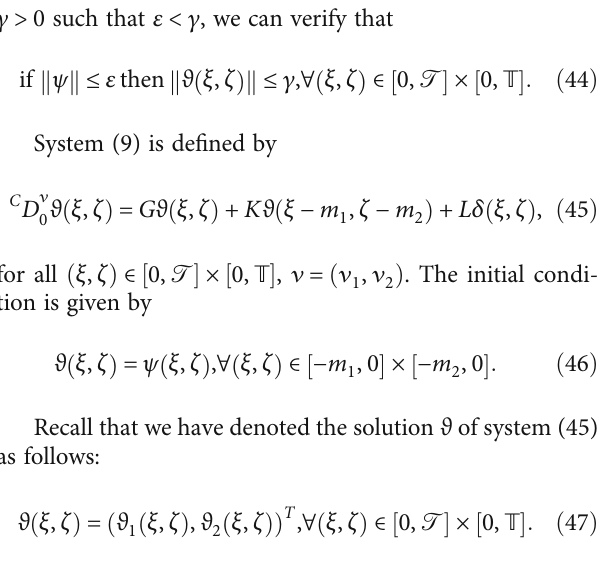
, ϑ T , T = 1 : 2 , T = 0 : 7 , and ν = ð 0 : 9,0 : 2 Þ . The curves of ϑ 1 2 Þ